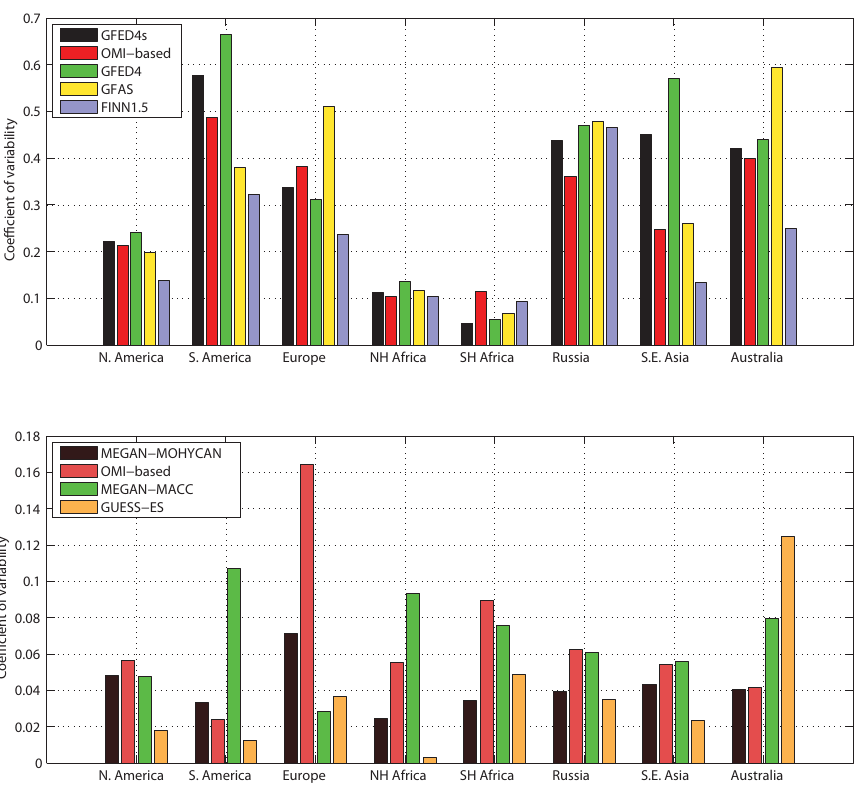
Figure 4. Interannual variability expressed as coefficient of variation, defined as the standard deviation of the emissions divided by the mean of the emissions, given for the a priori, for the OMI-based emission estimates, and for the independent emission inventories of biomass burning (upper panel), and isoprene emissions (lower panel) over the big regions defined in Fig. 3.